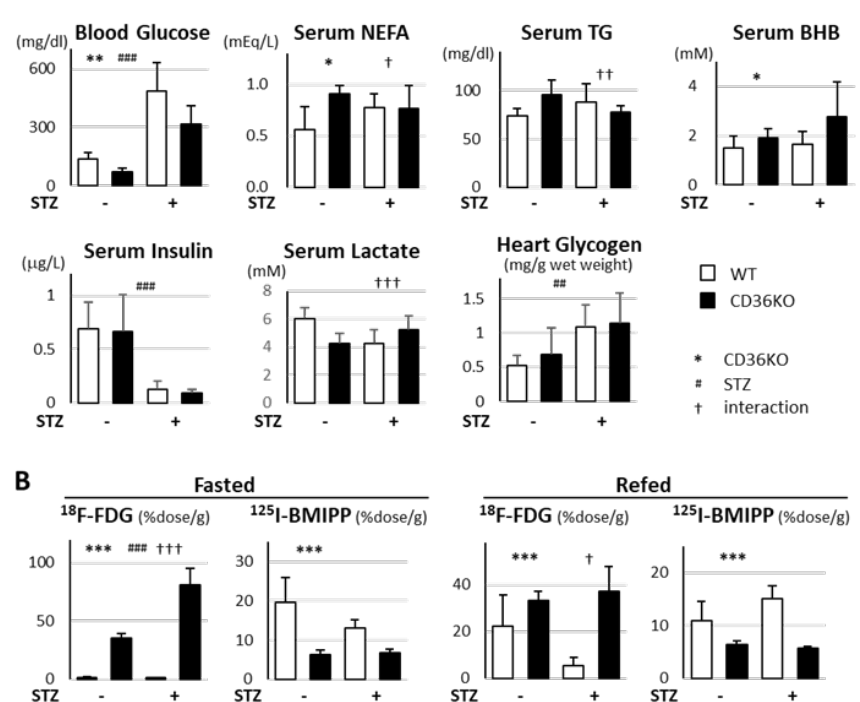
Figure 2. Circulating levels of metabolites and uptake of glucose and FA tracers by hearts in absence or presence of STZ treatment. ( A ) Blood samples were collected after a 6 h fast to measure serum levels of glucose, NEFA, TG, BHB, insulin and lactate ( n = 5–7). Glycogen in hearts was also measured. NEFA, non-esterified fatty acids; TG, triacylglycerol; BHB, β -hydroxybutyrate. ( B ) Uptake of 18 F-FDG (glucose tracer) and 125 I-BMIPP (FA tracer) by hearts was assessed 2 h after intravenous injection ( n = 5–7). * p < 0.05, ** p < 0.01, *** p < 0.001; main effect for genotype. # p < 0.05, ## p < 0.01, ### p < 0.001; main effect for STZ treatment. † p < 0.05, †† p < 0.01, ††† p < 0.001; interaction